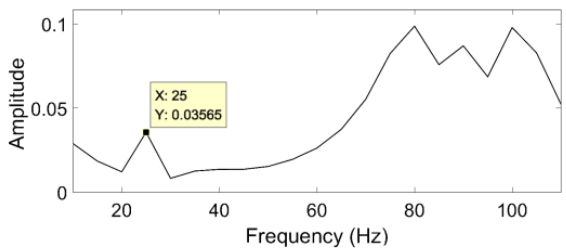
Figure 27. FFT of current i gd in voltage drop condition.